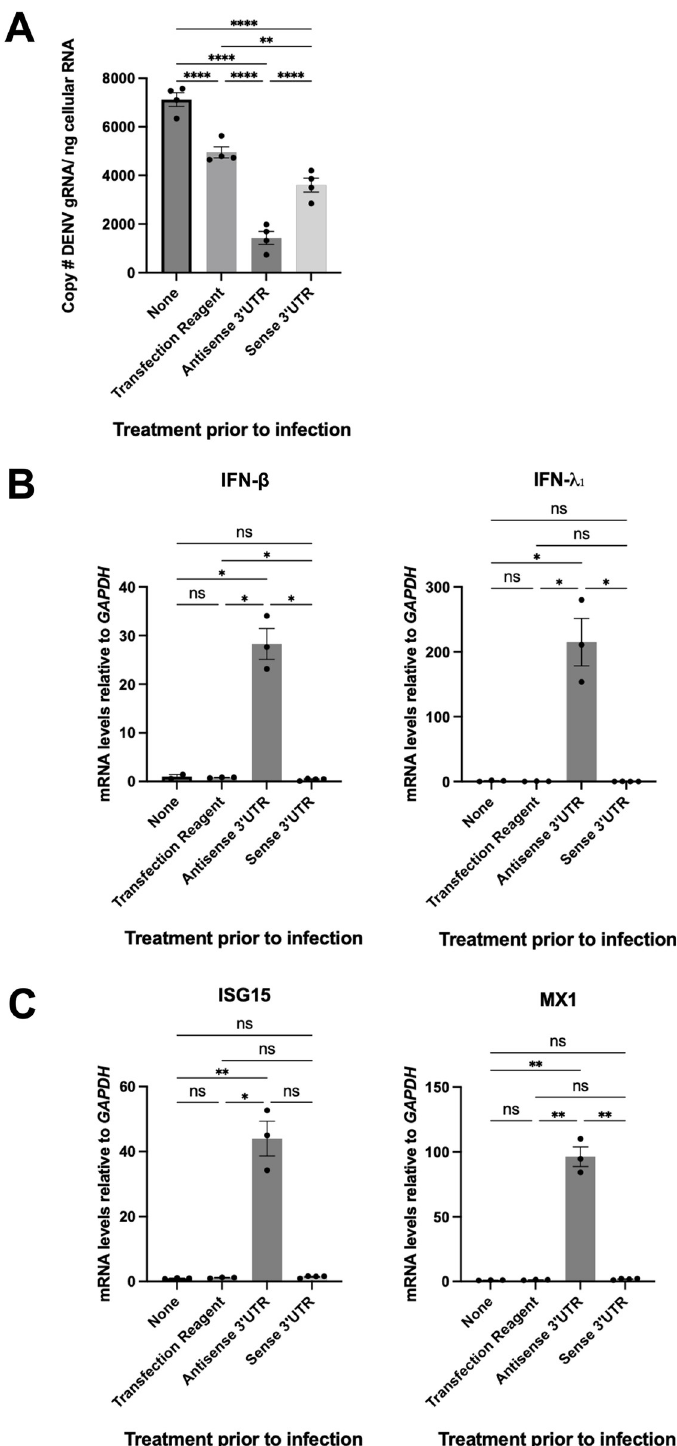
Fig 5. DENV2 3’UTR enhances DENV2 gRNA viral levels while inhibiting innate immunity. Huh-7 cells were either regularly infected (non-treated), or 2 hours prior to infection transfected with sense DENV2 3’UTR, antisense DENV2 3’UTR or lipofectamine alone. 17 hours post infection total cellular RNA was extracted and (A) Absolute copy number of intracellular DENV2 gRNA was measured by qRT-PCR. �� , p-value � 0.005, ���� , p-value � 0.0001 as determined by a Fisher’s LSD test. (B) Relative mRNA transcript levels of IFN- β and IFN- λ